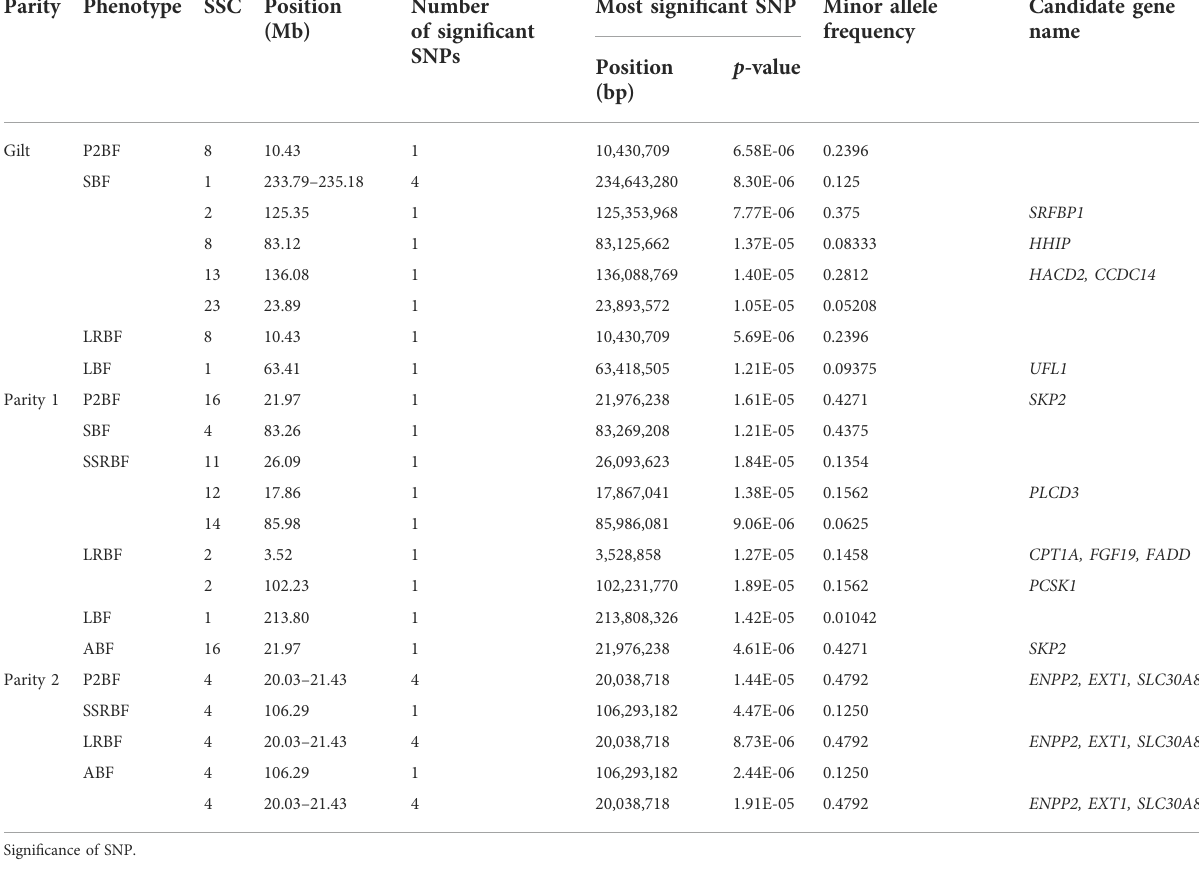
TABLE 5 Summary of genomic regions signi fi cantly associated with six backfat traits in Yunan pigs.